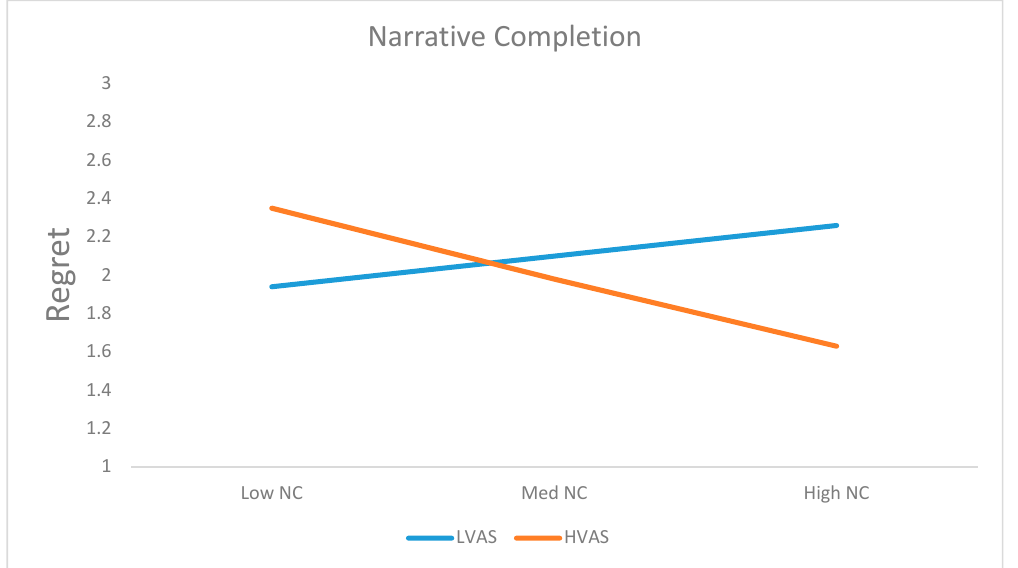
Figure 2. Attentiveness moderates narrative completion and regret.